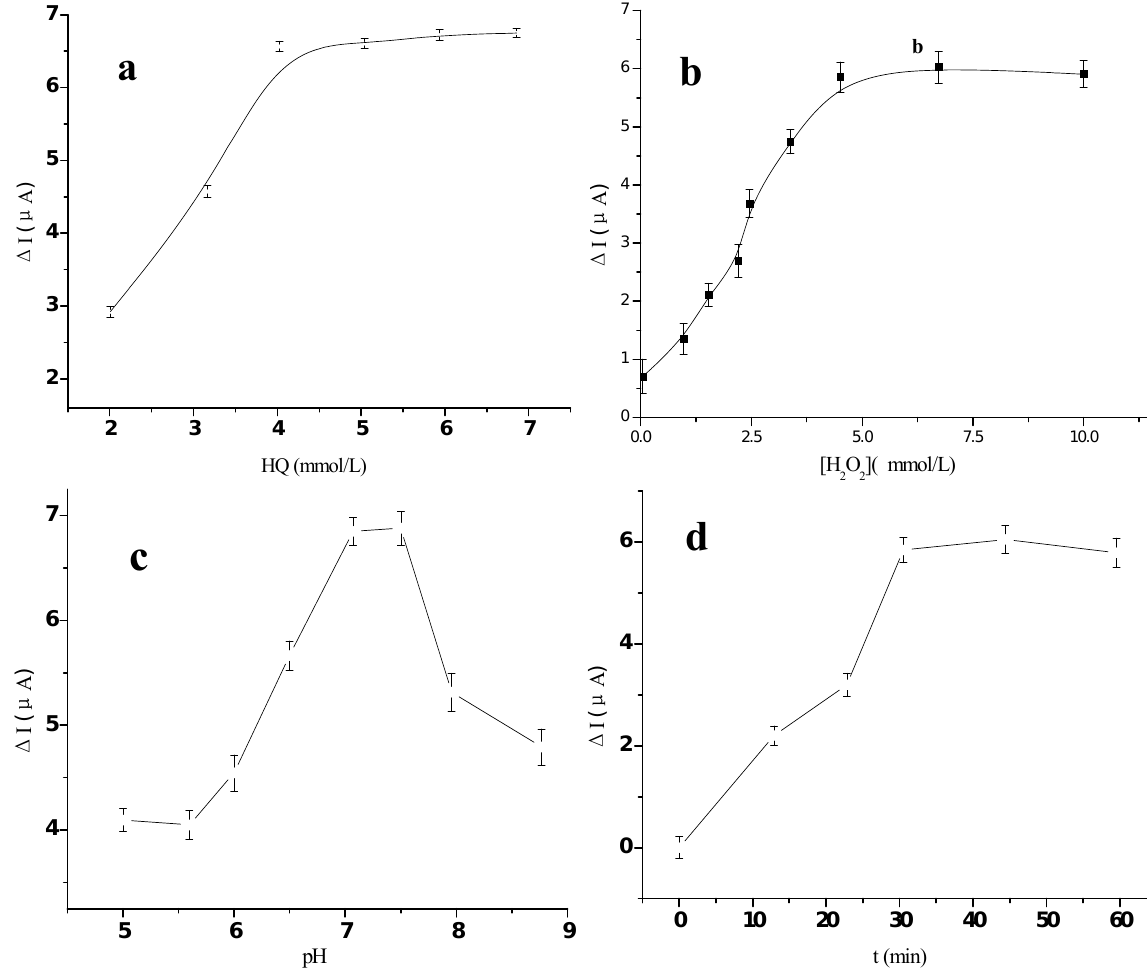
Figure 6. The effect of different ( a ) concentration of HQ; ( b ) Concentration of H ( c ) pH to the anodic peak currents responses for the immunosensor; ( d ) Incubation time after the immunosensor was incubated with 0.5 ng/mL p24